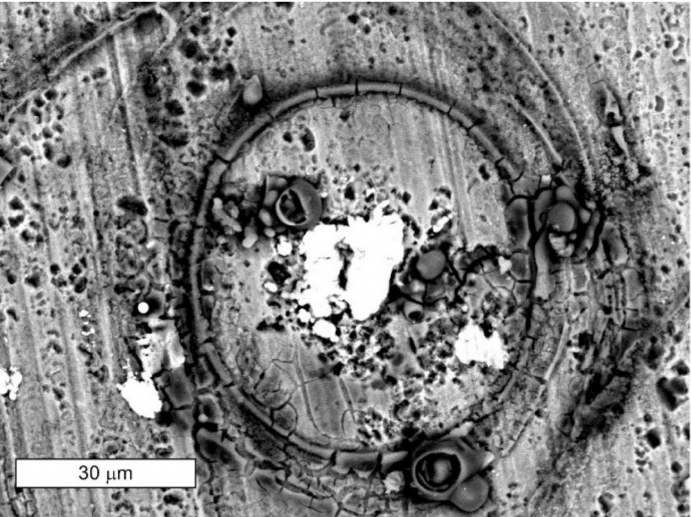
Figure 20. Corrosive changes evidencing the formation of tubercles during electrochemical tests on the surface of the sample in RRA state,